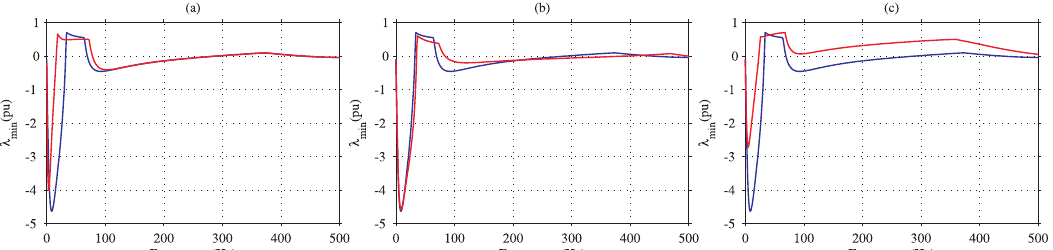
Figure 4. Frequency characteristics of the index λ min from 0–500 Hz with variation in control parameters; ( a ) closed-loop bandwidth for the power controllers as 6 Hz (blue) and 3 Hz (red); ( b ) closed-loop bandwidth for the current controller as 300 Hz (blue) and 450 Hz (red); and ( c ) parameters of the virtual impedance as R v = R f , L v = L f (blue) and R v = 1.5 R f , L v = 1.5 L f (red).